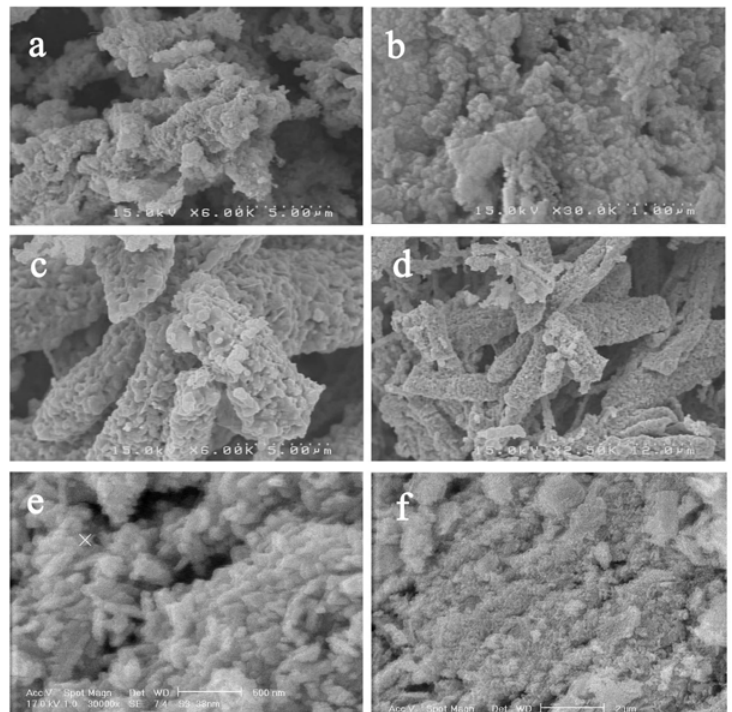
Fig. 7. SEM photographs of CuO nanostructure produced by calcination of [Cu